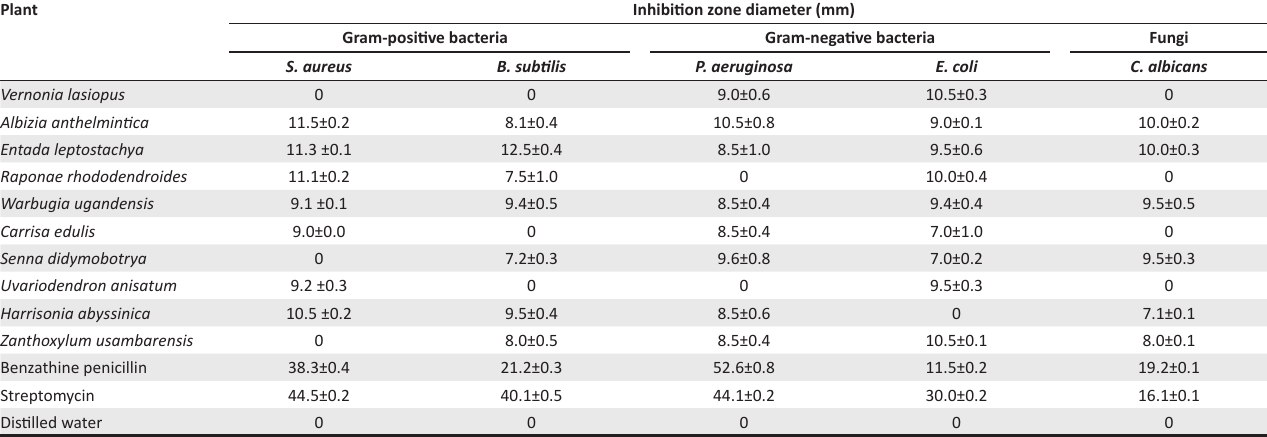
TABLE 3: Antimicrobial susceptibility tests of extracts from surveyed plants. Plant